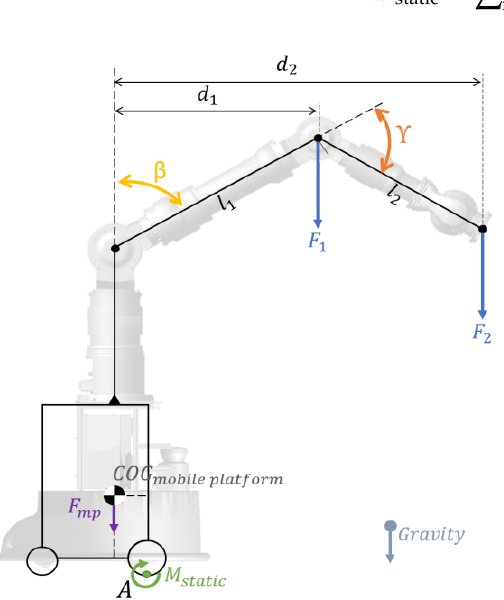
Figure 6. Free body diagram of mobile manipulator.